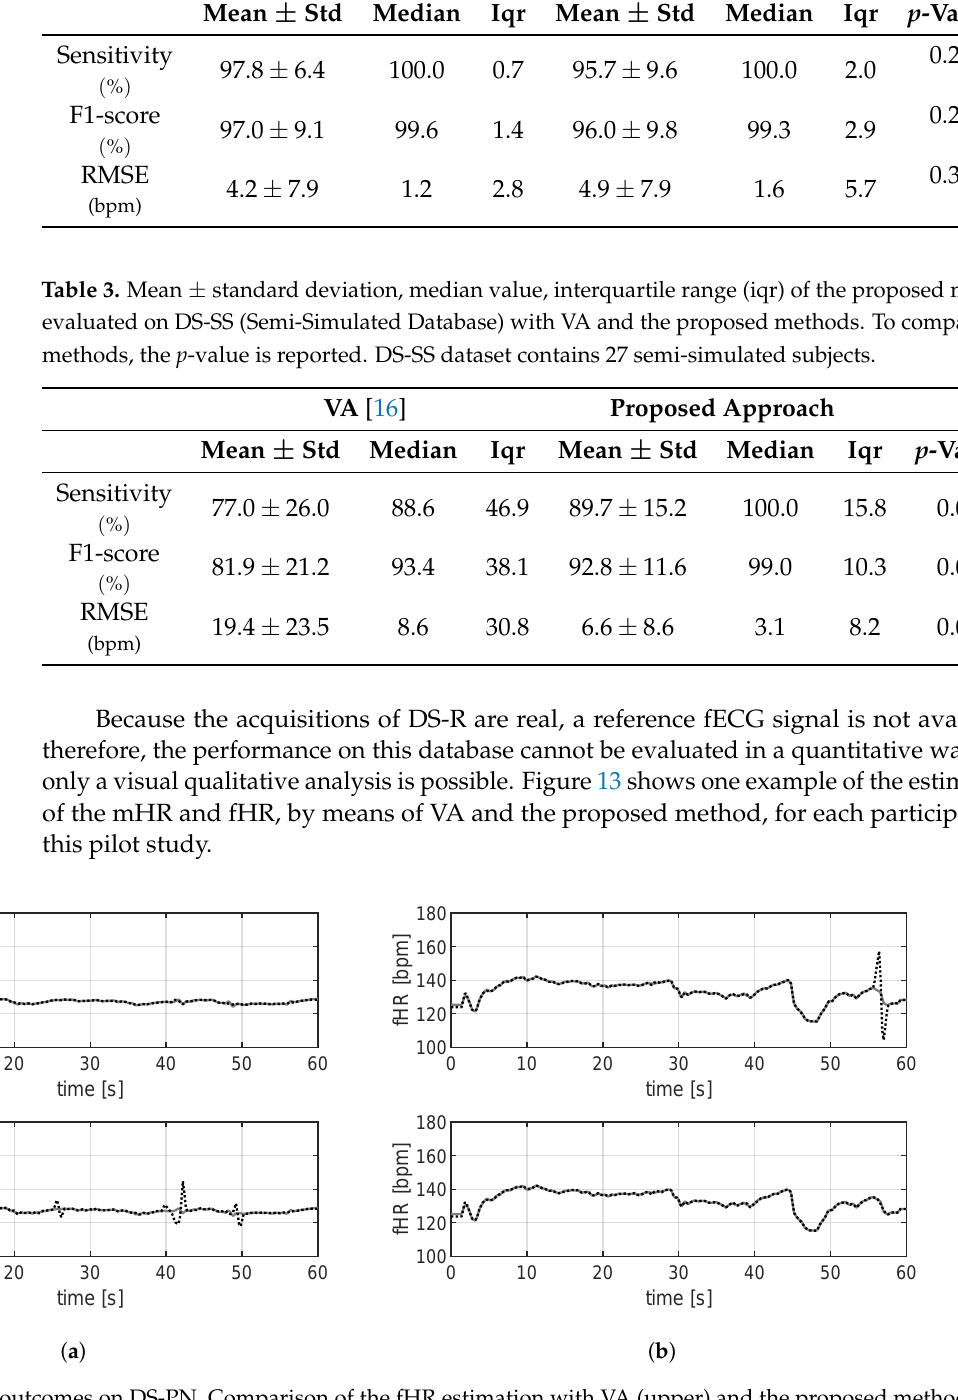
Figure 10. Examples of outcomes on DS-PN. Comparison of the fHR estimation with VA (upper) and the proposed method (lower), the reference is the gray line. ( a ) Record a19. ( b ) Record